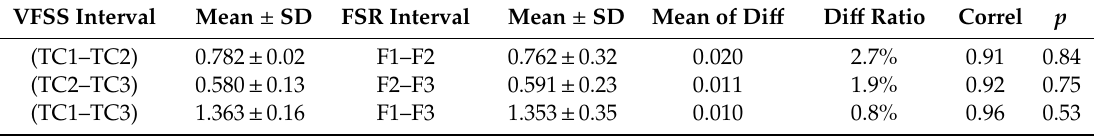
Table 4. Comparison of the VFSS intervals (sec) with the FSR intervals (sec).